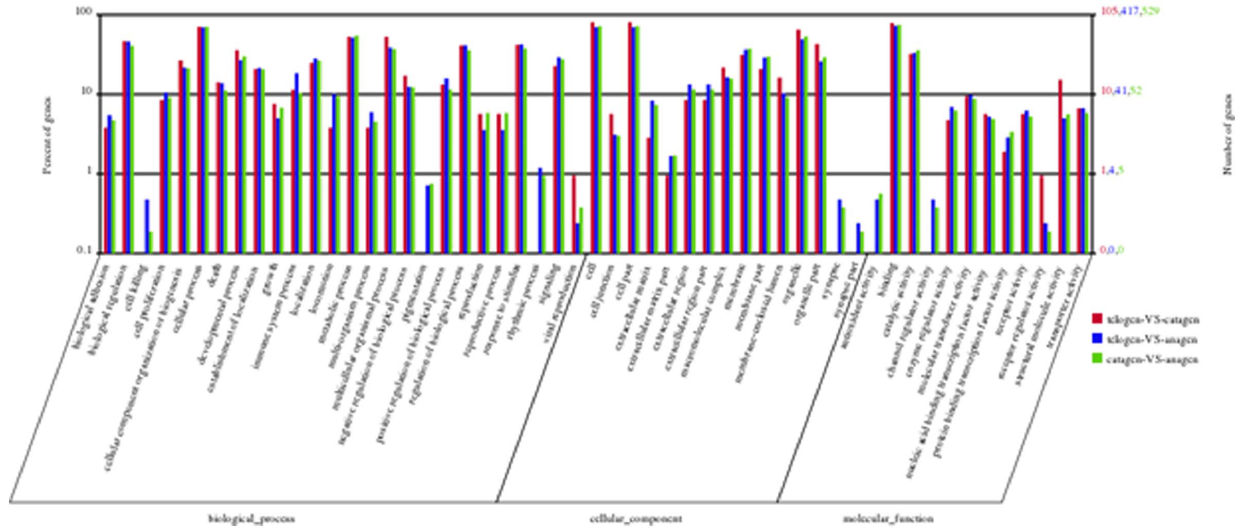
Figure 5. GO functional analysis of DEGs based on RNA-Seq data. The results were summarised in three main categories: biological process, cellular component and molecular function. Among these groups, the terms cellular process, cell & cell part and binding were dominant in each of the three main categories, respectively.